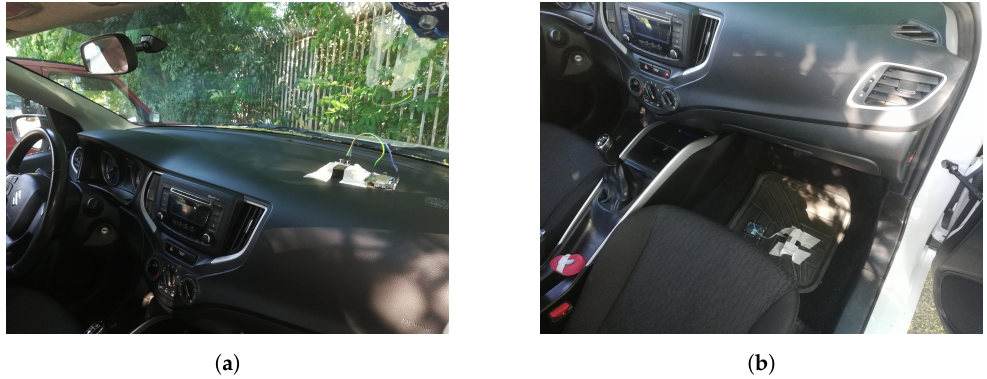
Figure 4. Onboard locations of the acceleration data acquisition system. ( a ) Acceleration sensor placed on the car’s dashboard; ( b ) Acceleration sensor placed on the car’s floorboard.